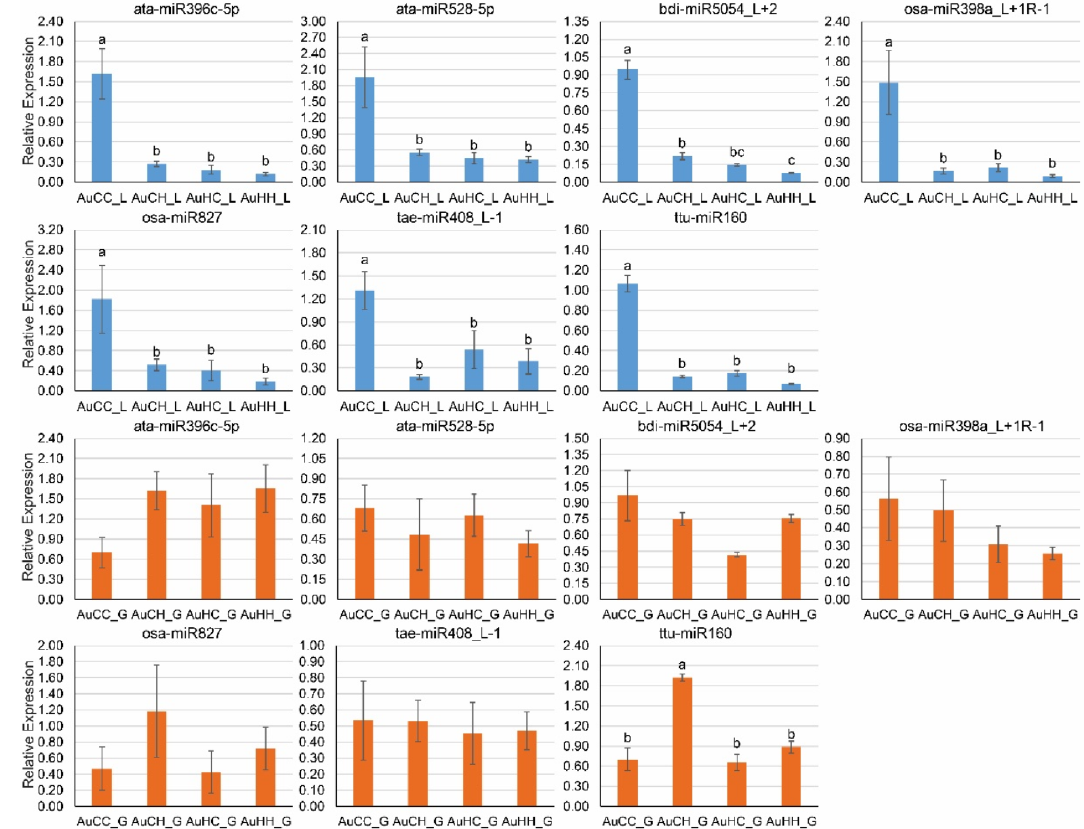
Figure 6. qPCR expression profiles of seven selected stress-responsive miRNAs in DBA Aurora. Relative miRNA expression was calculated using GAPDH as the housekeeping gene. Data are presented as the mean ± standard error (SE) ( n = 3). The treatment groups are: AuCC (DBA Aurora progeny treated with the control, originated from control group parents), AuCH (DBA Aurora progeny treated with heat stress, originated from control group parents), AuHC (DBA Aurora progeny treated with the control, originated from heat stress group parents), AuHH (DBA Aurora progeny treated with heat stress, originated from heat stress group parents). _L indicates flag leaf samples (highlighted in blue) and _G indicates developing grains samples (highlighted in orange). One-way ANOVA analysis was performed to identify statistical significance across treatment groups ( p < 0.05). Different letters (a, b, c) represent significant statistical difference across treatment groups based on the l.s.d